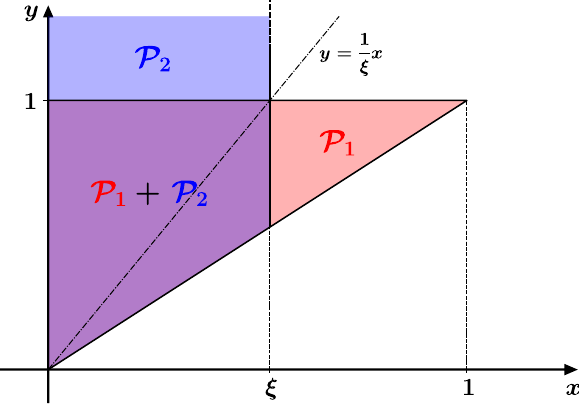
Fig. 2 Integration domain covered by the convolution integral in the r.h.s. of the evolution equations in Eq. (28). The coverage of the single functions P 1 and P 2 according to the decomposition in Eq. (32) is shown in red and blue, respectively. The dot-dashed line corresponding to y = x /ξ is relevant in that, along this line, both P 1 and P 2 separately diverge (see Sect.